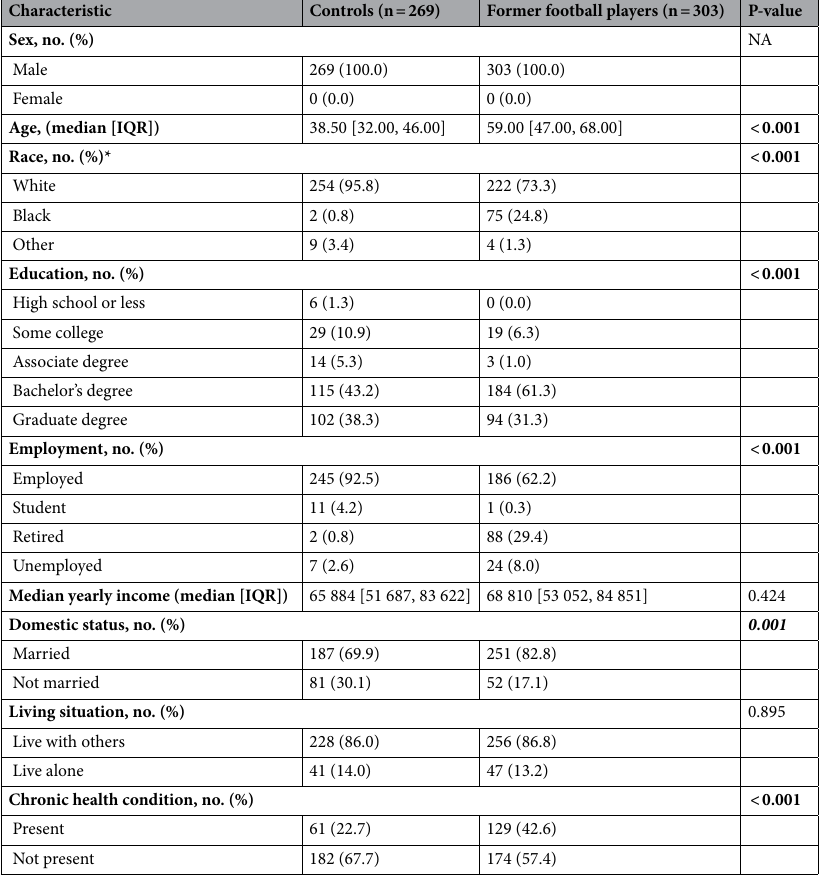
Table 1. Baseline characteristics of